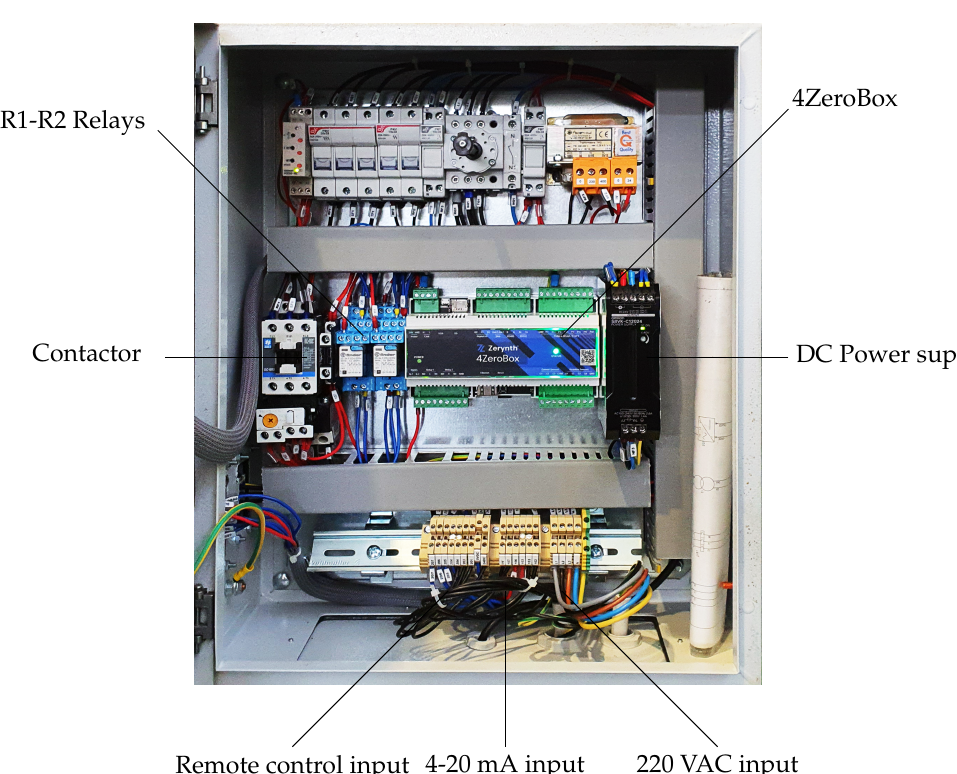
Figure 4. IIoT-enabled electrical cabinet